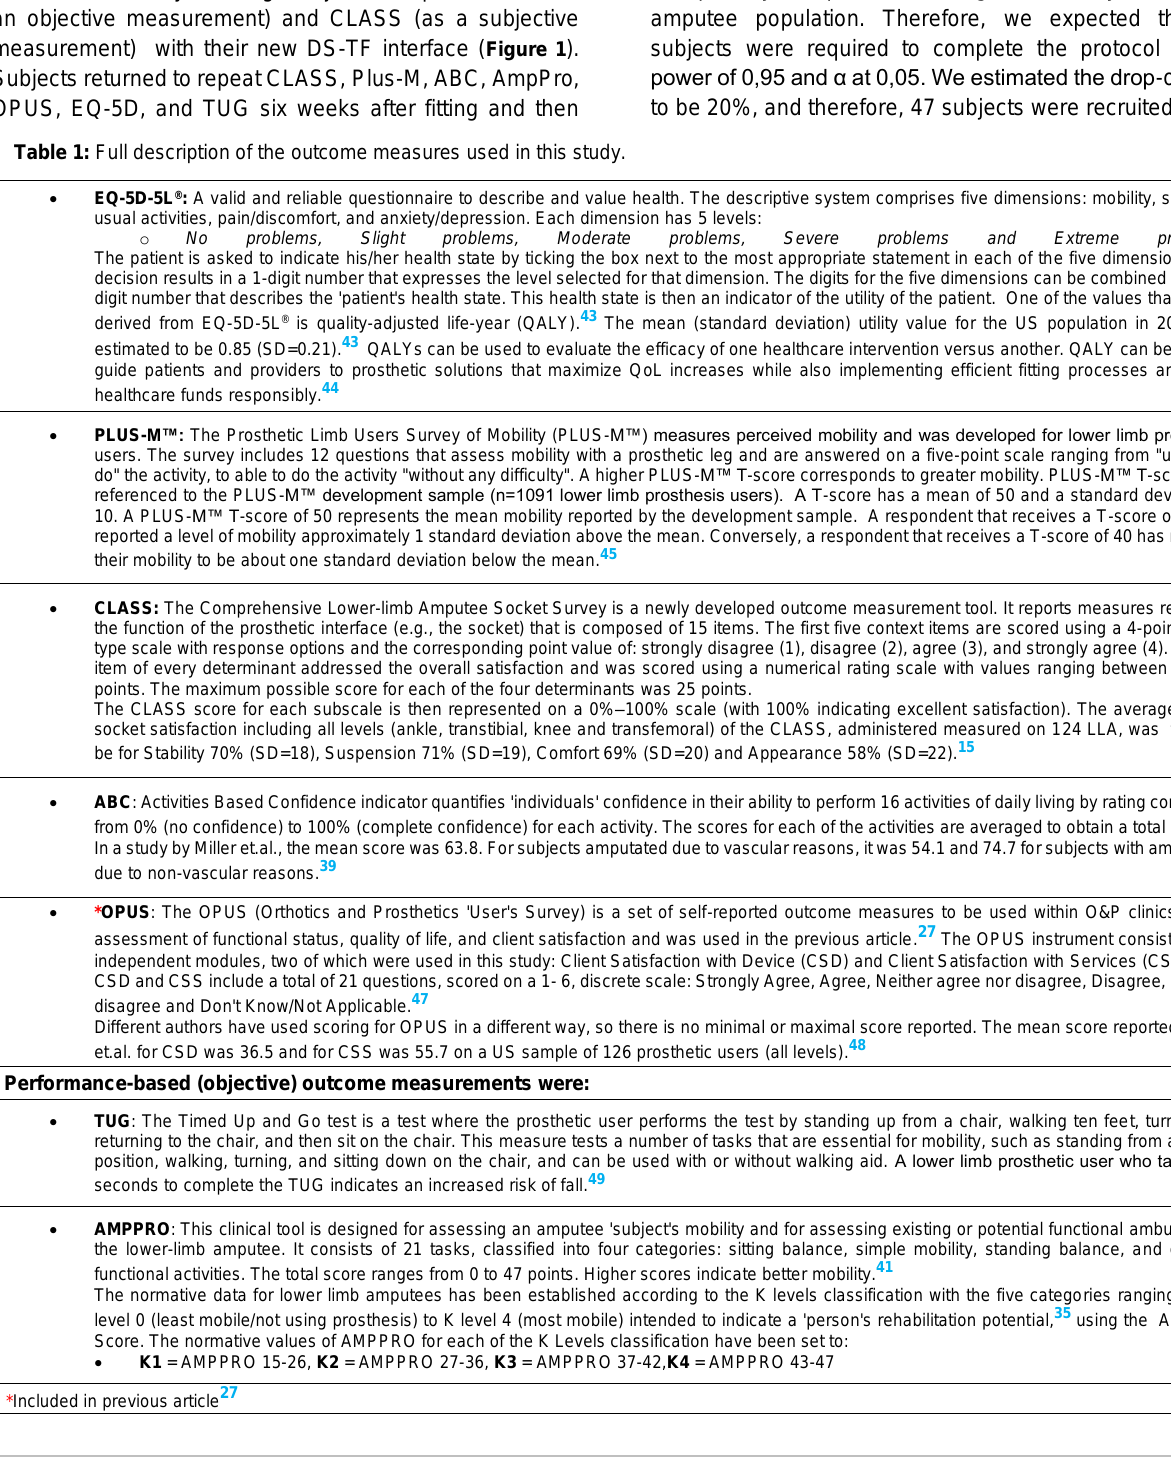
validating prosthetic care to payor sources. 42 Table 1 contains full description of the outcome measures used.